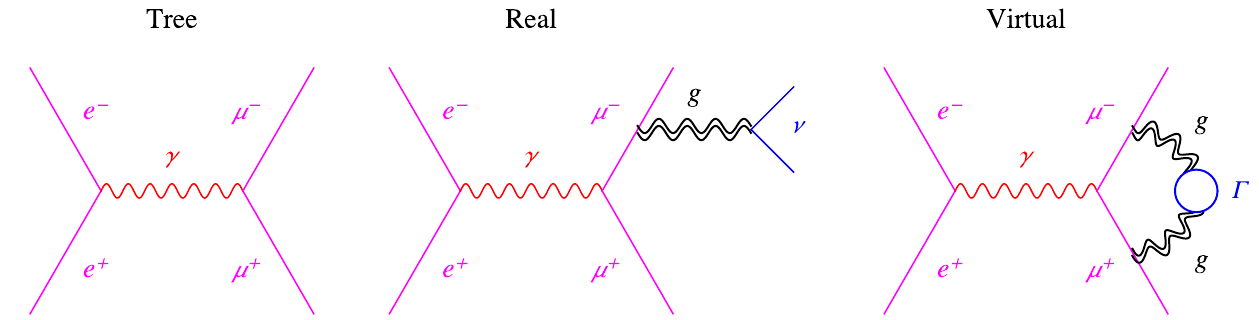
Fig. 3 A sample process. The second diagram, computed with real (Minkowskian) moments, has an IR power enhancement at large gravi-ghost momenta, k = ( E , E , 0 , 0